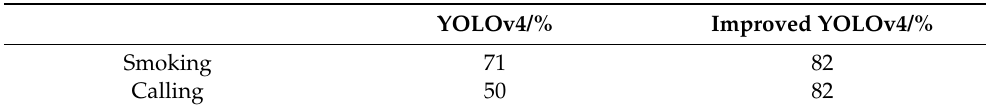
Table 3. Comparison between the original YOLO algorithm and the improved YOLO algorithm used in this article.